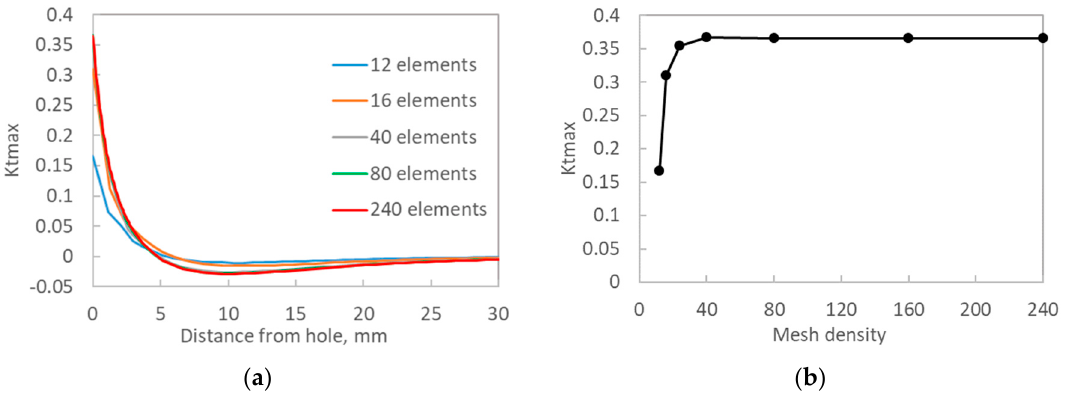
Figure A3. Convergence of ( a ) the normalized interlaminar normal stress distribution along the plotting path shown in Figure A1 and ( b ) the interlaminar tensile stress concentration factor K max with mesh refinements.